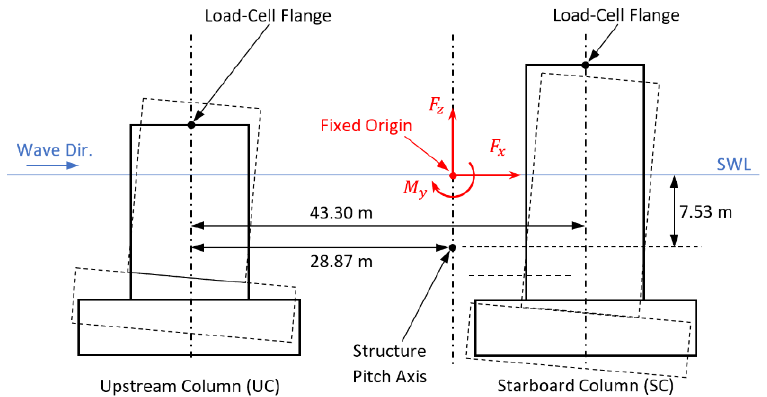
Figure 11. Coordinate-system convention for the surge force F x , heave force F z , and pitch moment M y in the final dataset [6]. The directions of F x , F z , and M y along with the fixed origin about which M y is computed (highlighted in red) remain the same irrespective of the configuration and column. For single column configurations, the column was always placed at the upstream column position. All dimensions are at full scale.